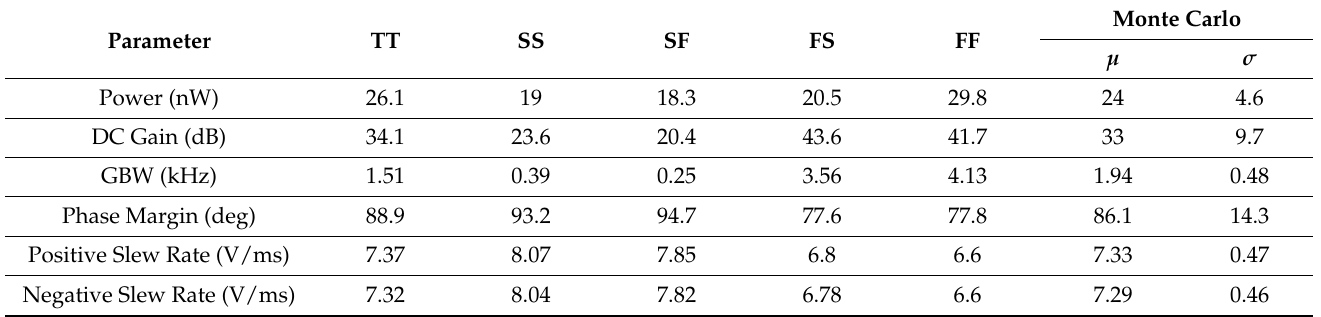
Table 3. Corner and Monte Carlo analysis results for T = − 10 ◦